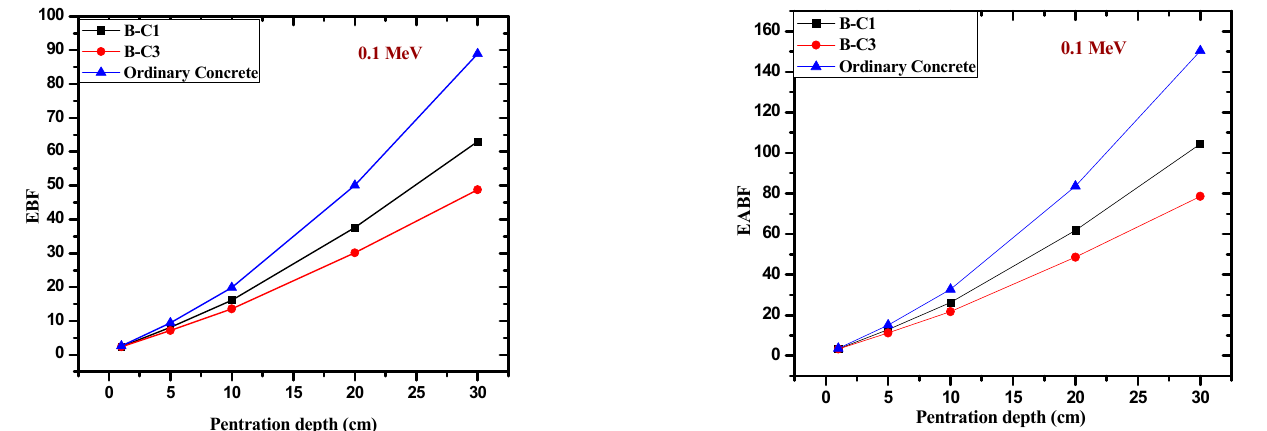
Figure 7. The variation of the EBF and EABF against penetration depth of the present samples compared with concrete at 0.1 MeV.